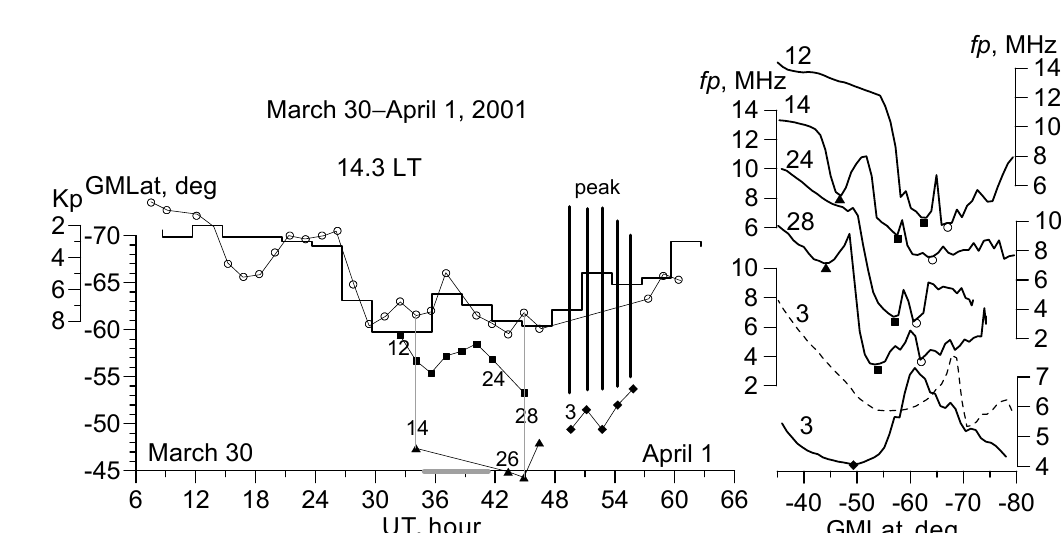
Figure 3. The variations in the trough positions during 30 March–1 April 2001, in the Southern hemisphere at 14.3 LT. The designations are the same as in Figure 1. Thick vertical lines show the peaks of ionization, the diamonds mark the fp minima equatorward of this peaks. The time is counted from 06 UT on 30 March.